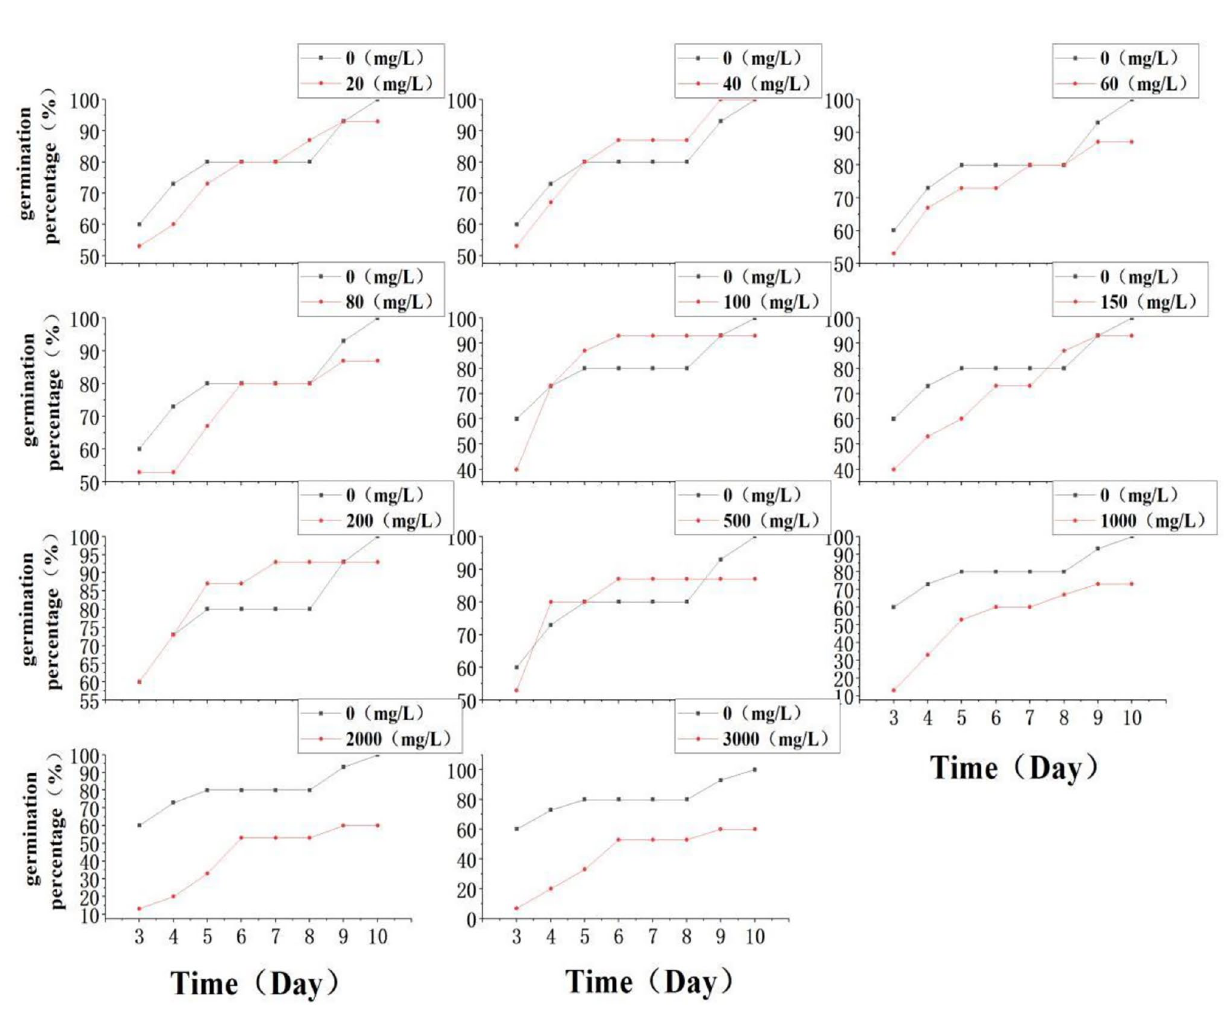
Fig. 2 Comparison of germination rate of maize seeds under the different Pb